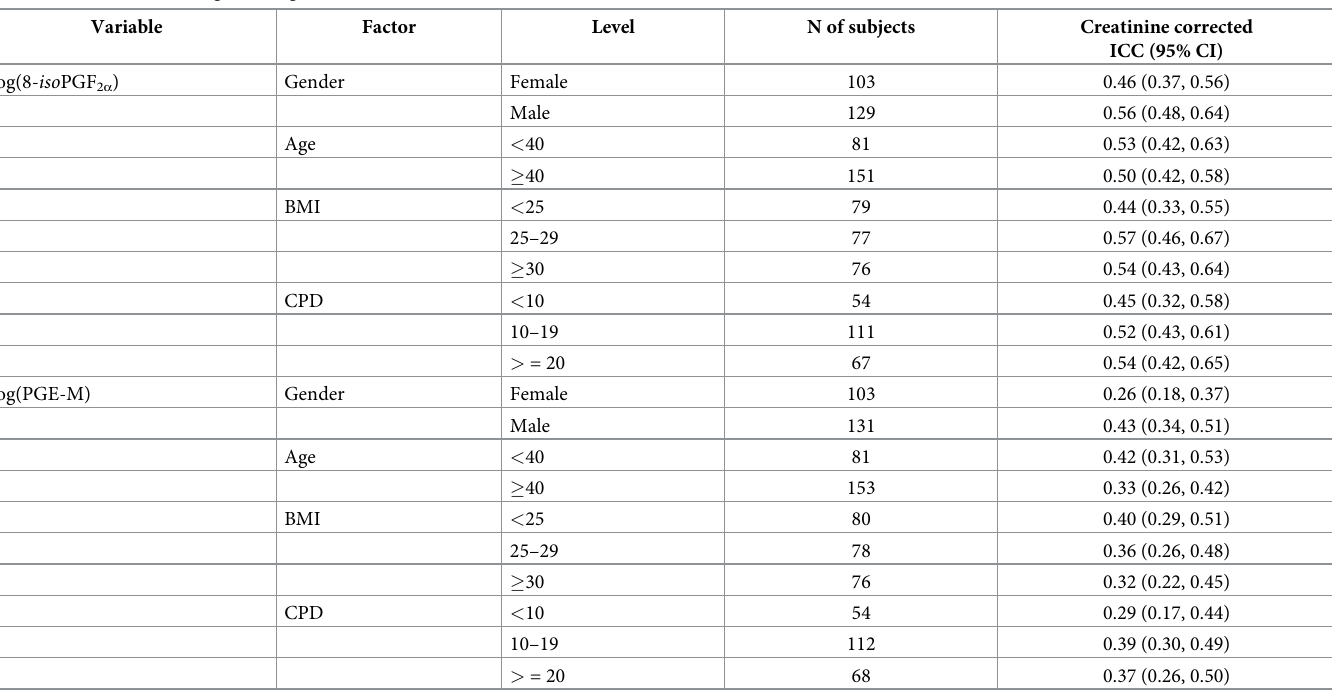
Table 2. Influence of CPD, gender, age, and BMI on ICC values of 8- iso -PGF 2 α and PGE-M.